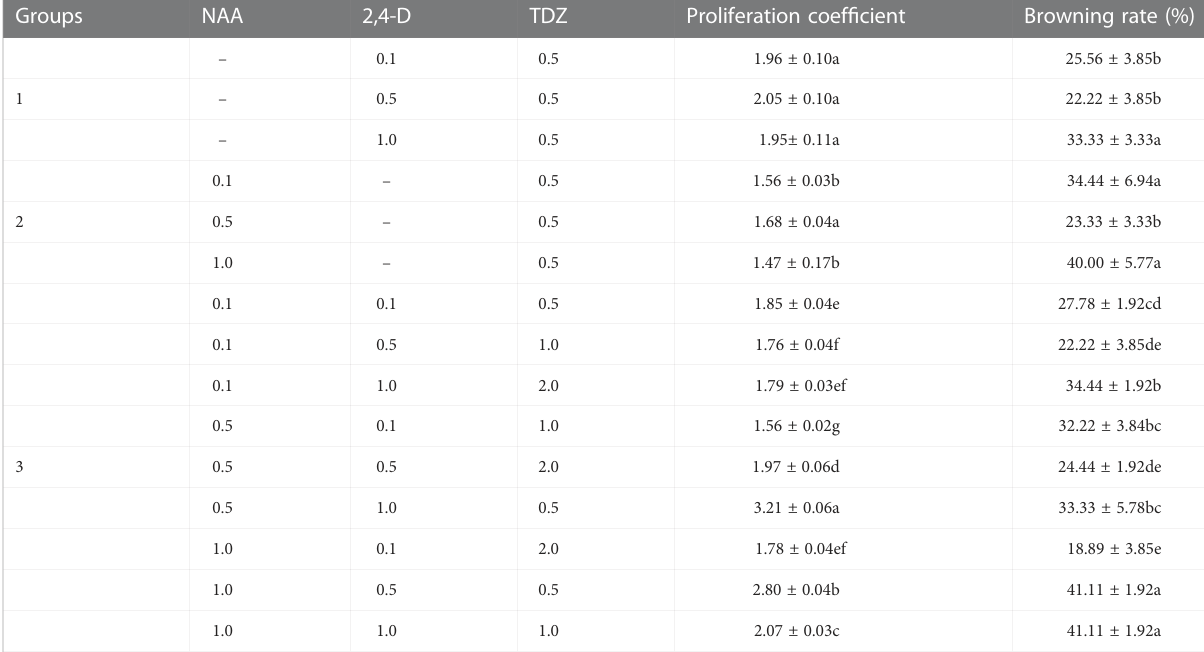
TABLE 2 Effects of NAA, 2, 4-D and TDZ on P. lacti fl ora callus proliferation.